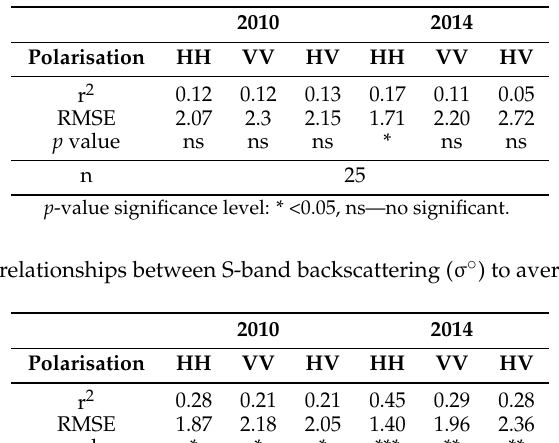
Table 4. Statistical relationships between S-band backscattering ( σ °) to basal area.